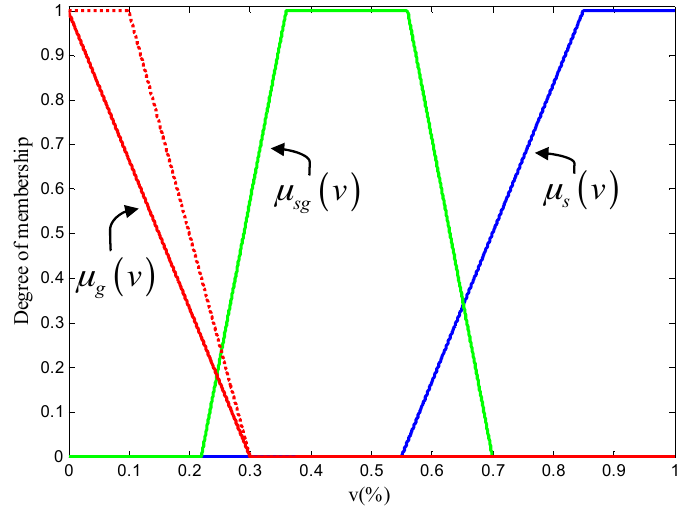
Figure 5. Membership functions of the SKY set (blue line), the HALF-SKY set (green line), and the GROUND set (red line). The red dotted line is the compared membership function of GROUND set.